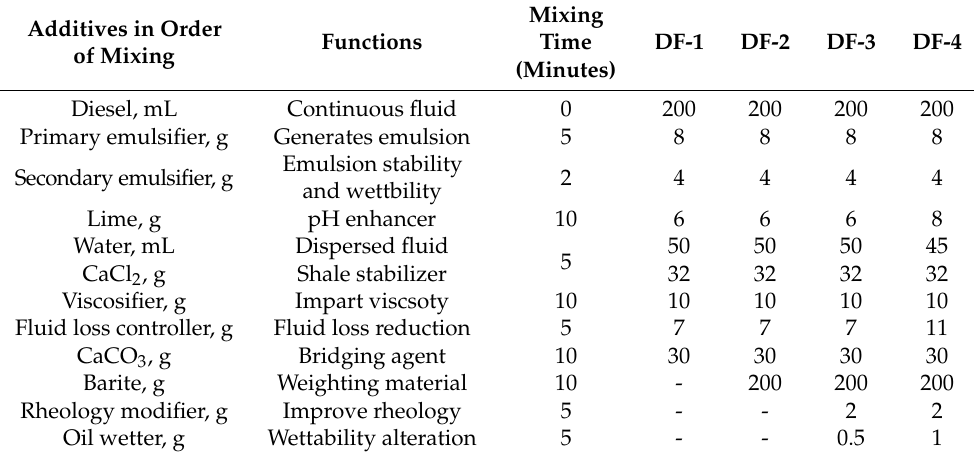
Table 2. Formulations of the